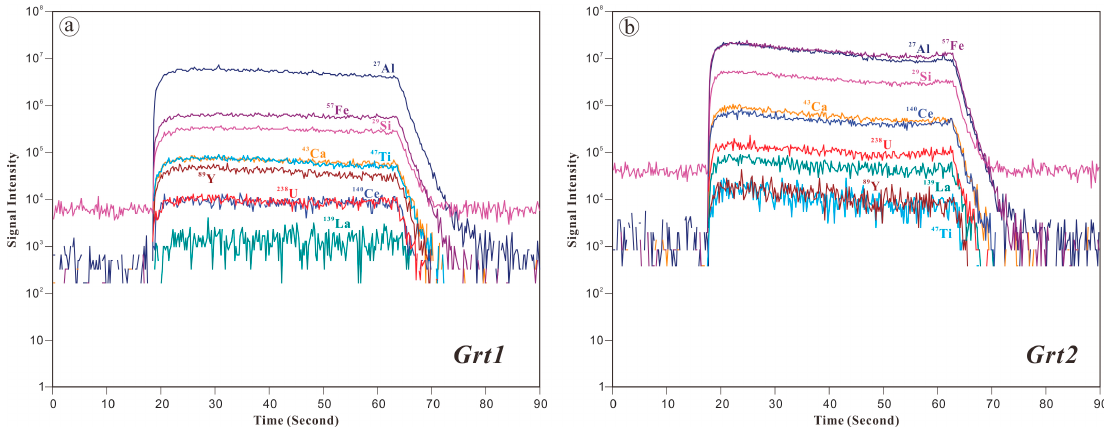
Figure 7. Representative time-resolved signals obtained by depth profile analyses of Grt1 ( a ) and Grt2 ( b ) from XQ37-1, showing flat and stable signals during laser ablation. ( b ) from XQ37-1, showing flat and stable signals during laser